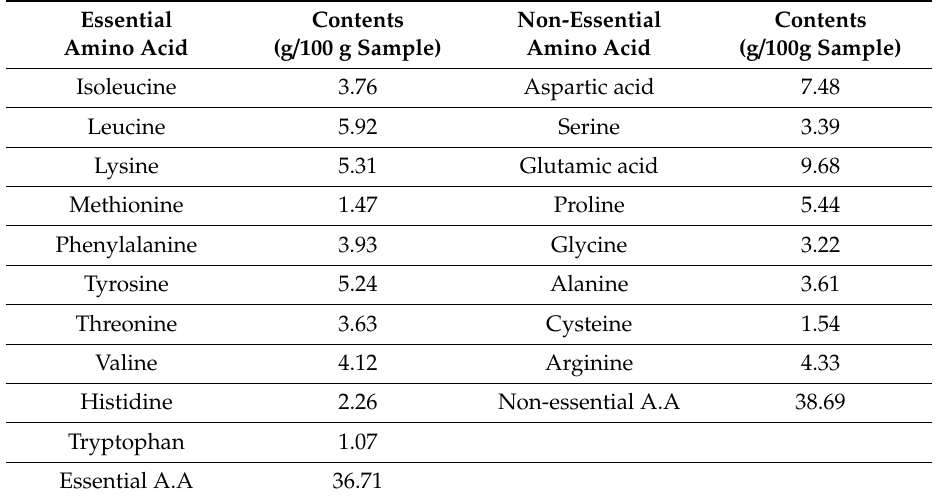
Table 3. Amino acid composition (g / 100 g sample) for the protein isolate of Protaetia brevitarsis seulensis